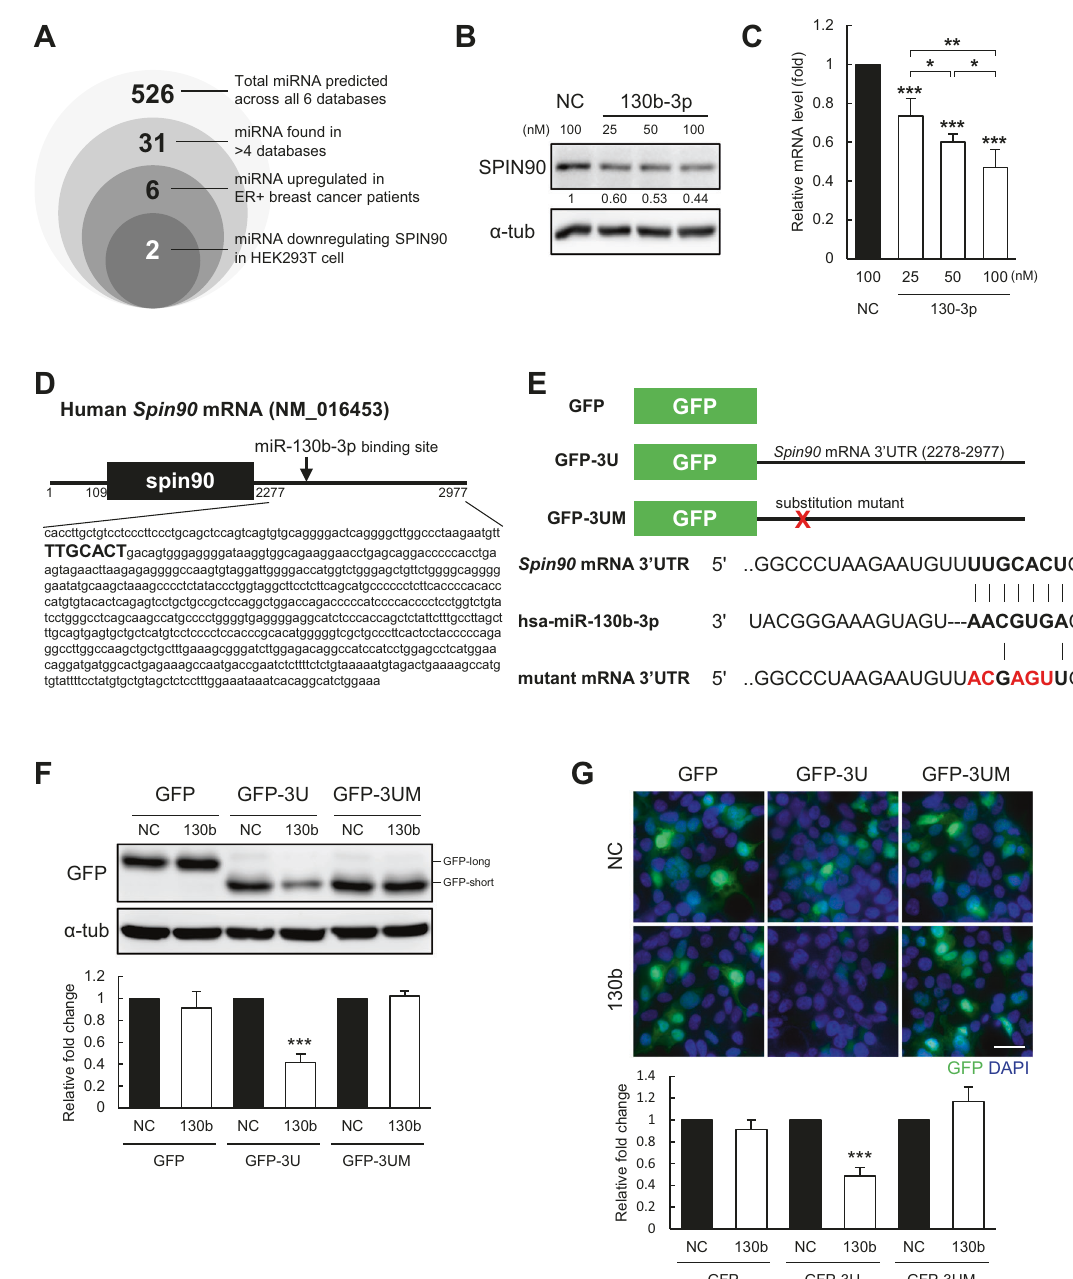
Fig. 2 miR-130b-3p inhibits SPIN90 expression by complementary binding. A Venn diagram showing the process used to narrow down candidate SPIN90-targeting miRNAs through in silico and in vitro analyses. B Western blot indicating the expression of SPIN90 in HEK-293T cells transfected with miR-130b-3p mimic or negative control ( n = 3). Relative protein levels were normalized to the expression of α -tub. C The Spin90 mRNA level was quanti fi ed by RT-qPCR assay in HEK-293T cells transfected with miR-130b-3p mimic or negative control ( n = 3). The relative mRNA level was normalized to the expression of Gapdh . D Sequence information of the Spin90 mRNA indicating the predicted binding site (bolded sequences) for miR-130b-3p. E Reporter gene constructs. GFP-3U indicates a GFP vector inserted with the 3 ’ UTR of the Spin90 mRNA, and GFP-3UM refers to a mutant construct lacking the binding site for miR-130b-3p. Bolded sequences, seed region. Red sequences, mutated region. F Reporter gene assay examined by Western blotting in HEK-293T cells co-transfected with reporter constructs and miRNAs ( n = 3). GFP protein size depends on the location of the stop codon in each reporter gene construct. G Immuno fl uorescence assays of reporter gene expression in HEK-293T cells ( n = 3). Scale bar, 50 μ m. All data are reported as mean ± standard deviation. *** p ≤ 0.001 by Student ’ s t -tests. NC negative control of the miRNA mimic; 130b and 130b-3p, miR-130b-3p showed that the expression of miR-130b-3p was notably higher in antibody to the epithelial marker E-cadherin. We found that 37.5% luminal A cell lines, including MCF7 and T47D cells, compared to of luminal A-type breast tumor tissues showed more than 2-fold other groups (Fig. 4C). Expression of the precursor of miR-130b-3p upregulation of miR-130b-3p compared to adjacent normal tissues, was also highly increased in luminal A cell lines (Supplementary Fig. whereas only marginal expression of miR-130b-3p was observed in S2B). However, there was only minimal expression of miR-130b-3p other types of breast cancer (Fig. 4B). Our RT-qPCR results also